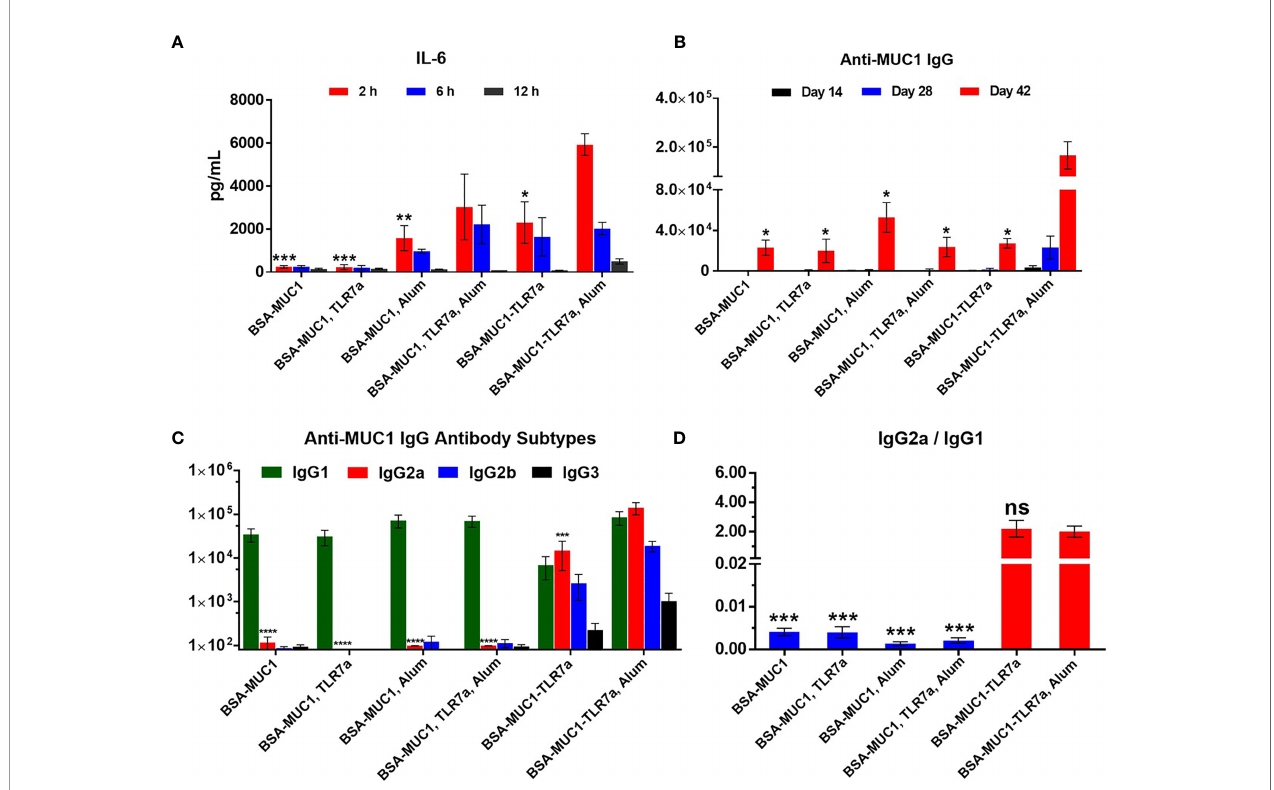
FIGURE 2 | (A) The secretion of the IL-6 cytokines in serum samples from immunized BALB/c mice with vaccine candidates at 2, 6, and 12 h, respectively. (B) Anti-MUC1 IgG antibody titers of each group on days 14, 28, and 42. (C) MUC1-speci fi c IgG antibody subtypes on day 42 and (D) the ratio of IgG2a/IgG1 of mice. The data are expressed as the mean ± SEM. Asterisks show signi fi cant difference compared with BSA-MUC1-TLR7a/Alum group based on one-way ANOVA by Dunn ’ s multiple comparison test (no signi fi cant difference, ns; * p ≤ 0.05, ** p ≤ 0.01; *** p ≤ 0.001; **** p ≤